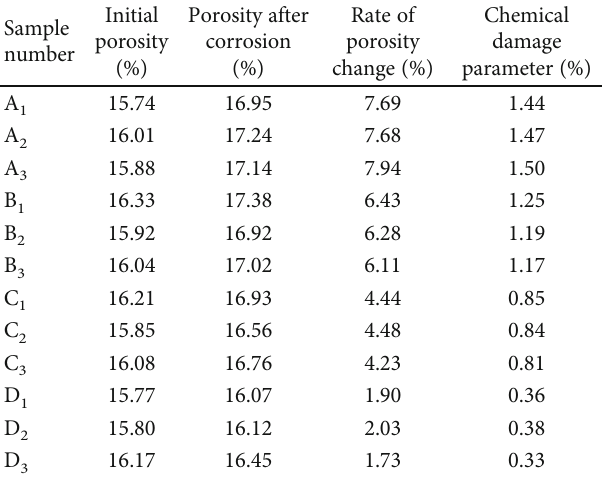
Table 2: Rock porosity and chemical damage parameters.